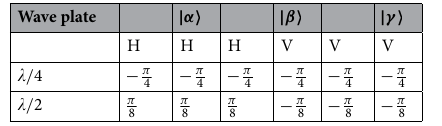
Table 2. The parameter settings for wave plates in the Brown Twiss